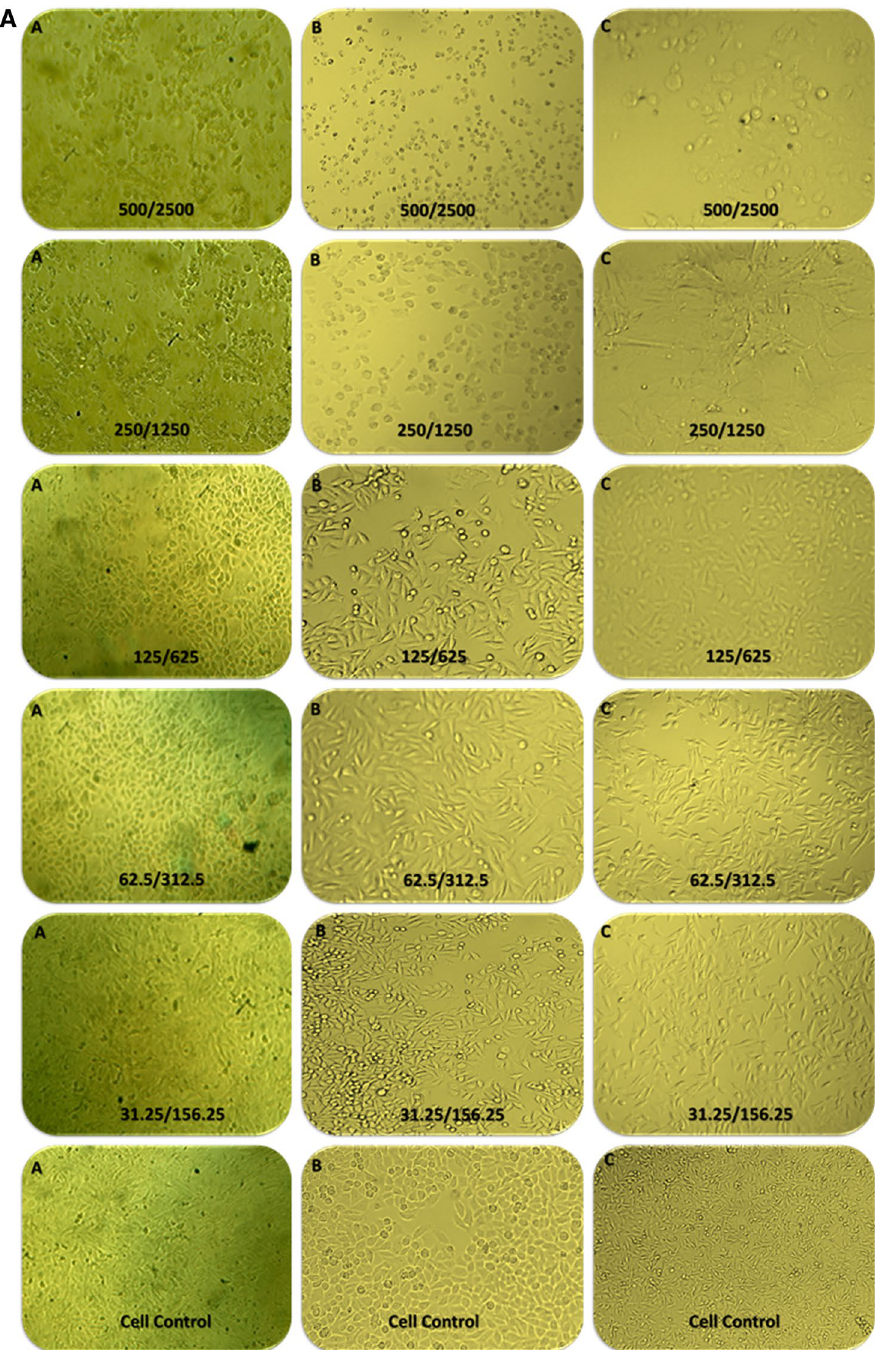
Figure 6. ( A ) Morphological observation of Vero cells (A), MRC-5 (B), and HBF4 (C) treated with different concentrations of penicillin and ZA-S combination under an inverted microscope. ( B ) Cytotoxicity results of gradient concentrations of penicillin and ZA-S combination on Vero, MRC-5, and HBF4 cells using MTT